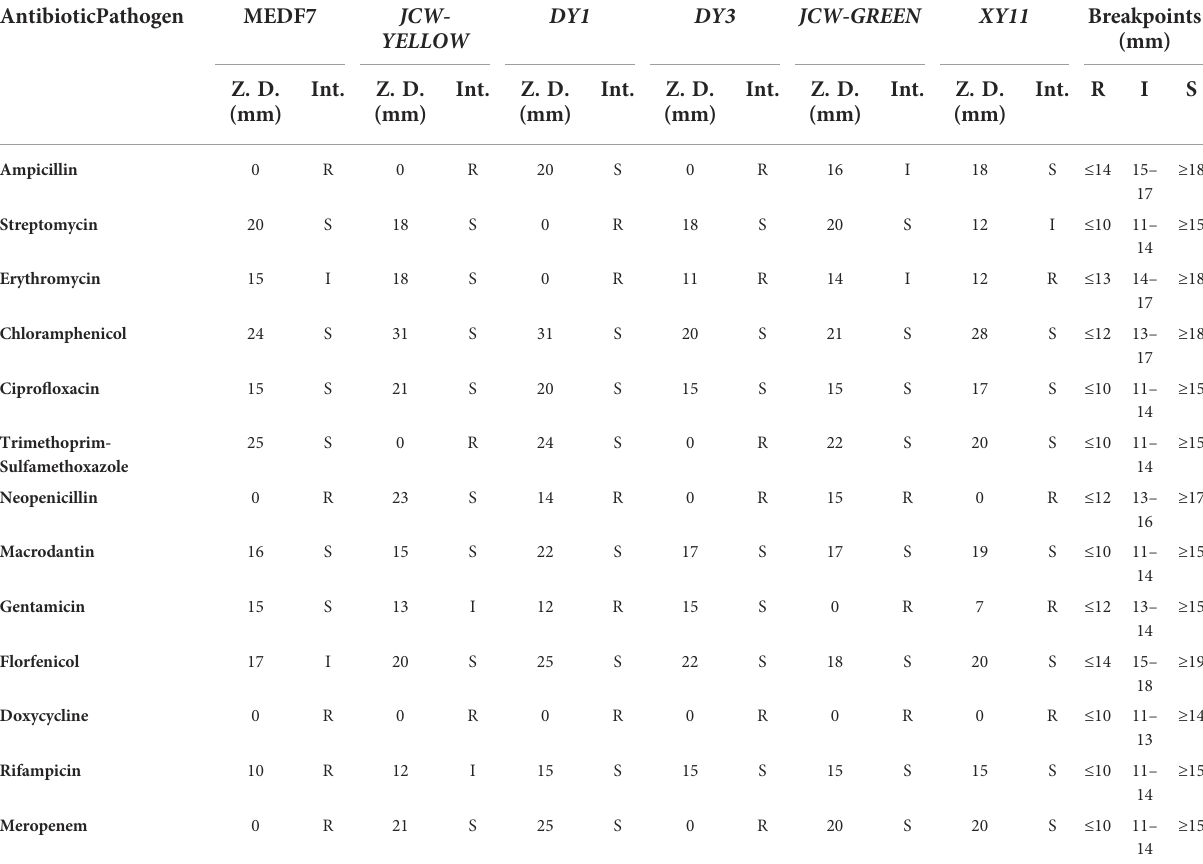
TABLE 6 Results of antimicrobial susceptibility test of 6 Vibrio strains.